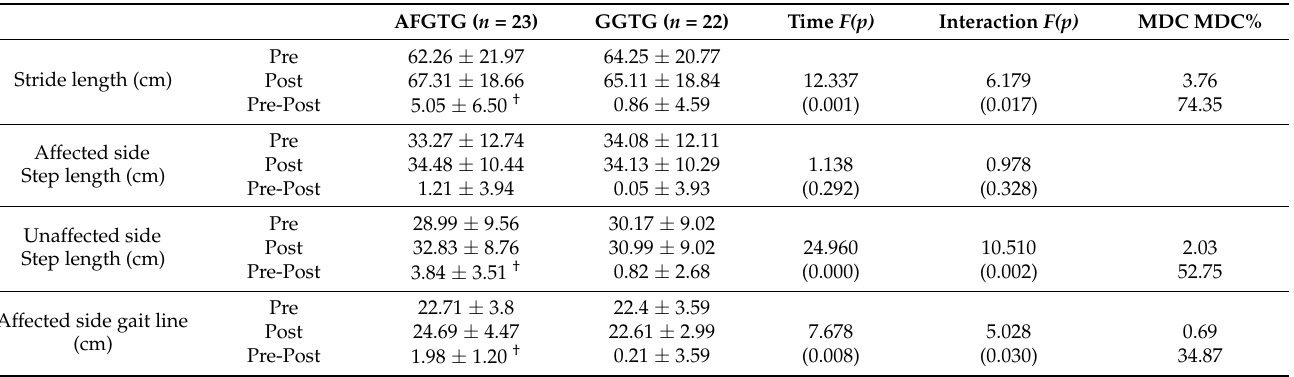
Table 3. Changes of spatial gait